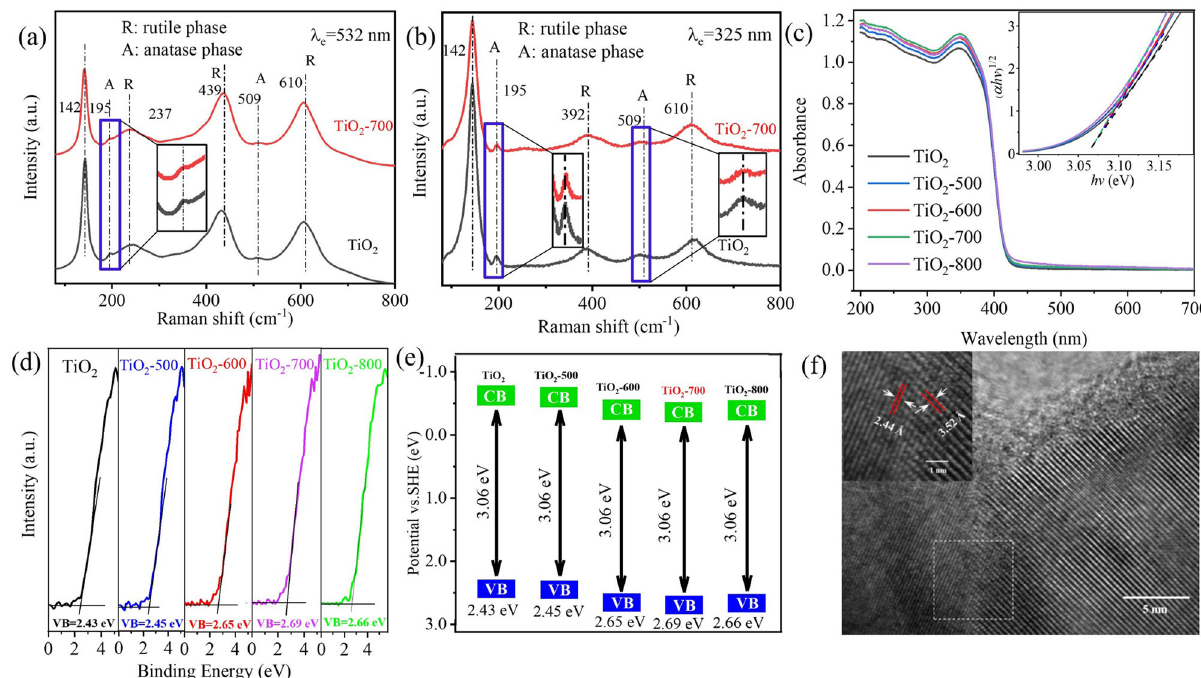
Fig. 3 Spectra and HRTEM image of the samples. a Visible Raman spectra, b UV Raman spectra, c UV – Vis spectra, d XPS spectra showing the valence band (VB) levels, e schematic of the band-gap structure, and f HRTEM image of the TiO 2 -700 sample.